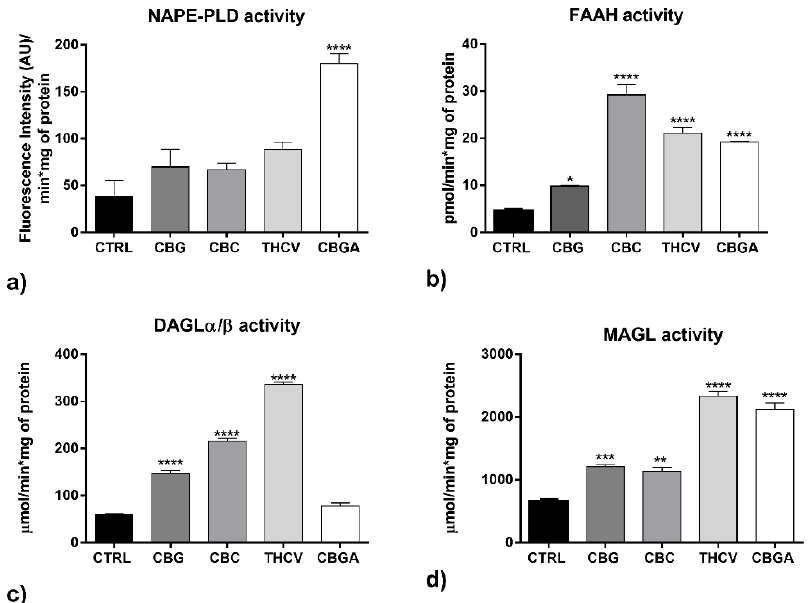
Figure 7. Activity of eCB metabolic enzymes: ( a ) NAPE-PLD, ( b ) FAAH, ( c ) DAGL α / β and ( d ) MAGL following 24 h of treatment with half-IC 50 amounts of CBG, CBC, THCV and CBGA. Data are the means ± SEM of three independent experiments ( n = 3). Statistical analysis was performed using a one-way ANOVA test, followed by the Bonferroni post hoc test (* p < 0.05, ** p < 0.01, *** p < 0.001 and **** p < 0.0001 vs. control).